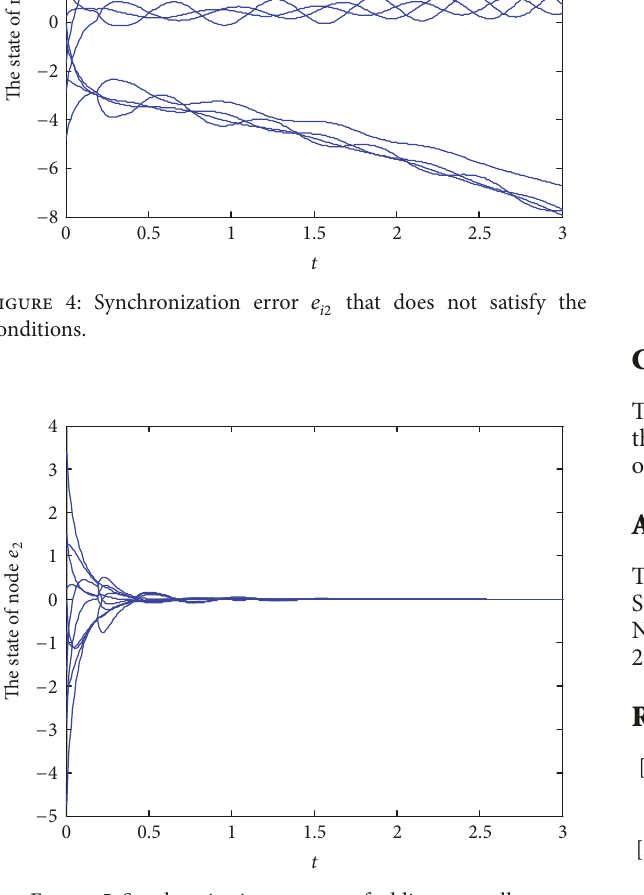
Figure 5: Synchronization error 𝑒 𝑖1 of adding controllers.